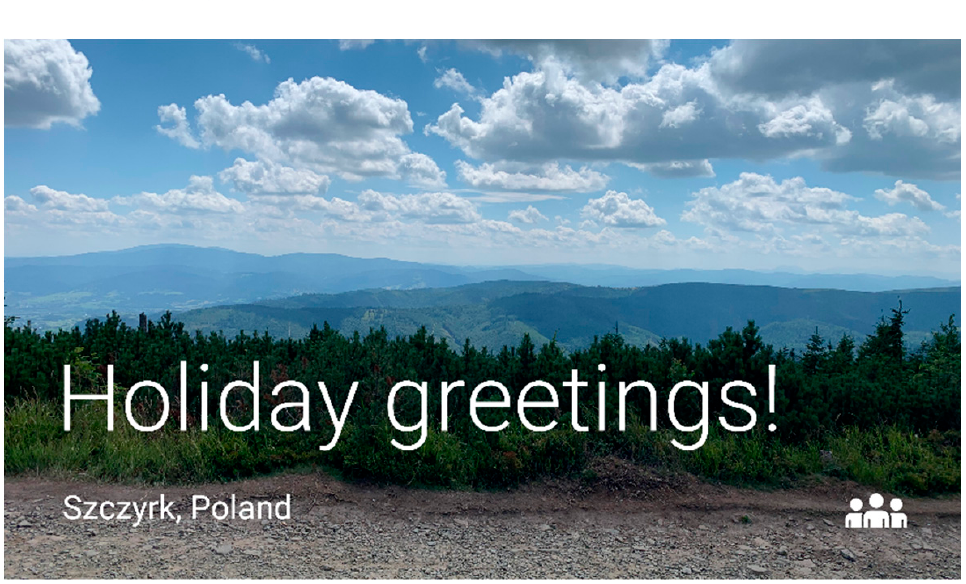
Figure 11. Story fragment consisting of a picture, caption, icon, and geolocation in Aphastory (screenshot from a Google Glass device).